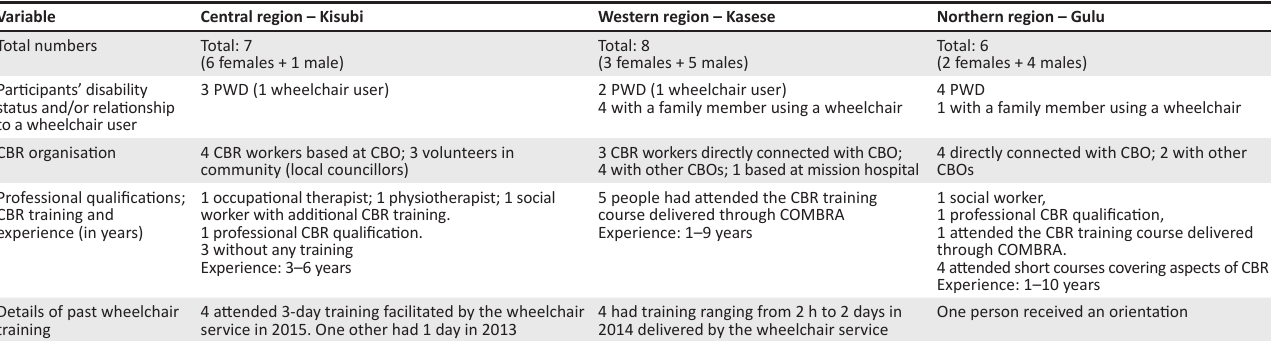
TABLE 4: Summary of participant profiles.